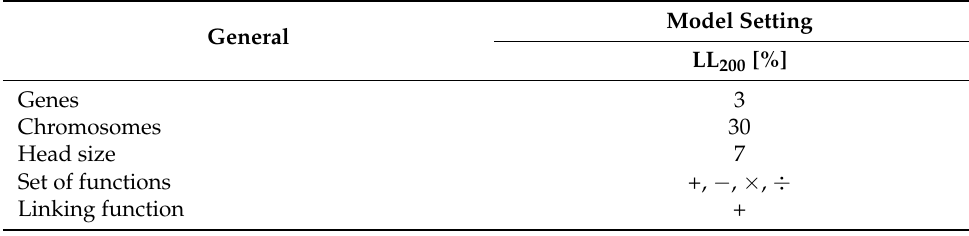
Table 2. General settings for the development of the prediction